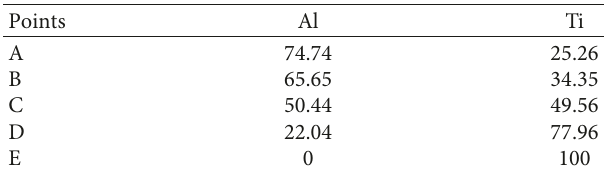
Figure 9: (a) Cross-sectional BSD image of Al coating after testing for 20 hours at 1173K, (b) the expanded view of region I in Figure 9(a), and (c) concentration profiles of Al, Ti elements in Figure Table 6: The chemical composition (at.%) in different points, as marked in Figure 9(b).